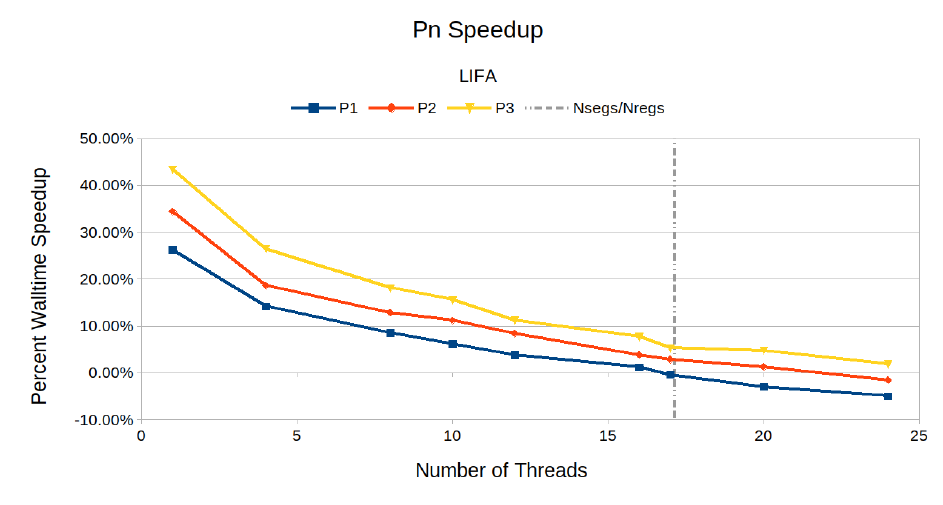
Figure 1: Angular Moments Optimization with